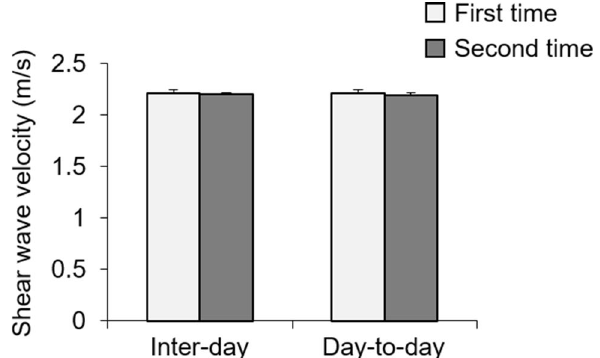
Figure 1. Shear wave velocities in konjac yam phantom jelly. Konjac yam phantom jelly was measured twice per day for 2 days with a between-measurement interval of 1 day. Data are presented as mean ± standard deviation (five measurements per trial).